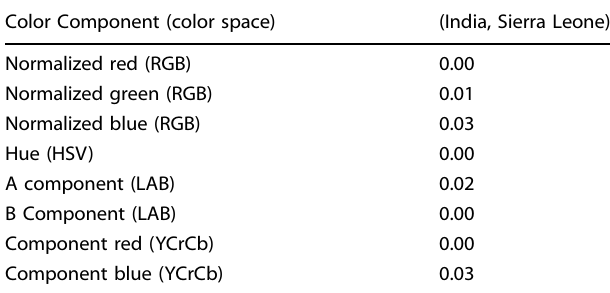
Fig. 4 Color space visualization of skin pixels from Sierra Leone and India. The sub-plots show the variation of skin pixel intensities of subjects from India (blue) and Sierra Leone (green) in the HSV Color space (top left), the Normalized RGB Color space (top right), the LAB Color space (bottom left) and the YCrCb Color space (bottom right). Table 10. KS test — p value comparison between population samples (gray shading highlights a statistically signi fi cant result).